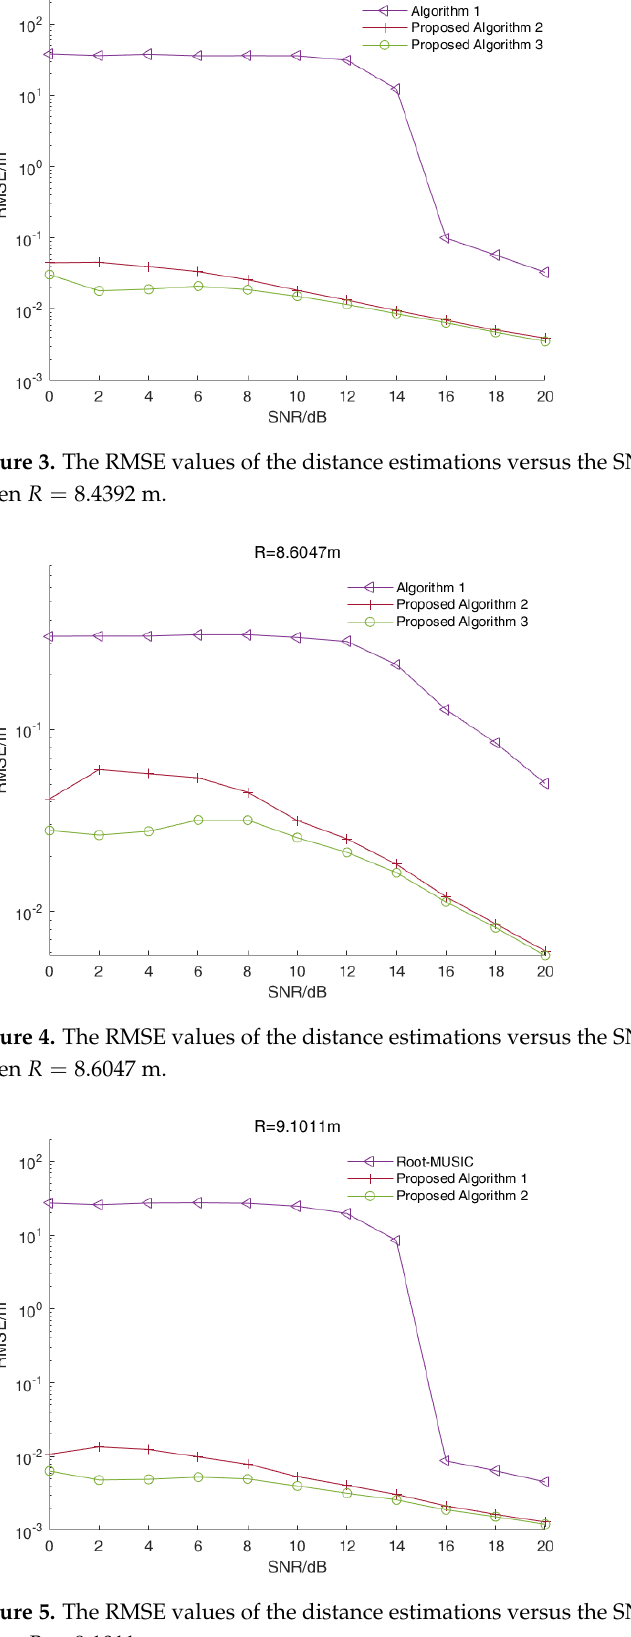
Figure 5. The RMSE values of the distance estimations versus the SNR values of all three algorithms when R = 9.1011